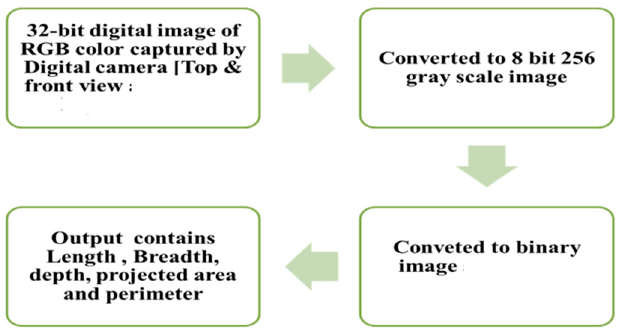
Figure 2. Image processing methodology of DIP.